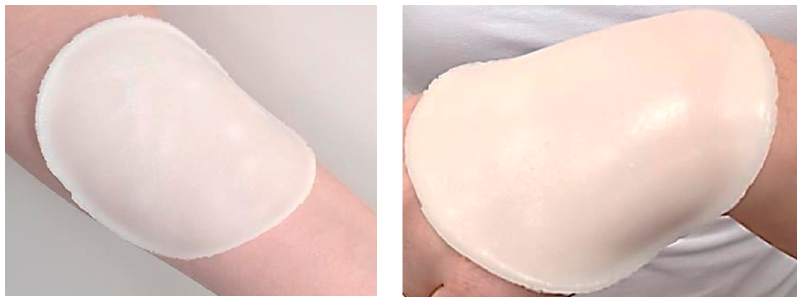
Figure 2. Example images of prepared hydrogel dressings (sample